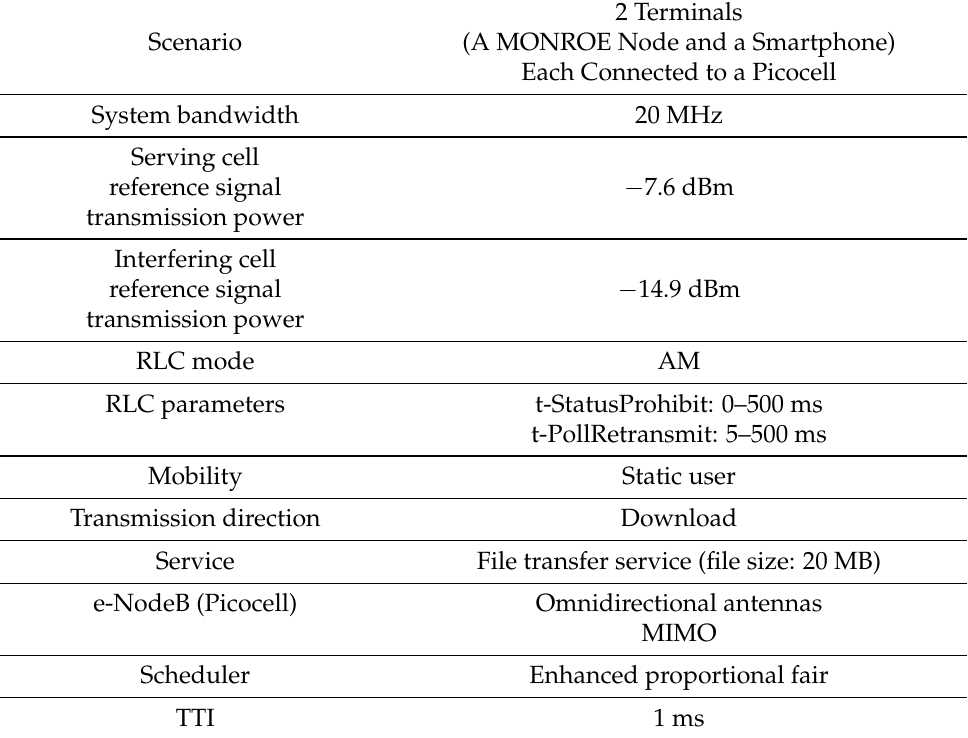
Table 2. Configuration of the UMAHetNet